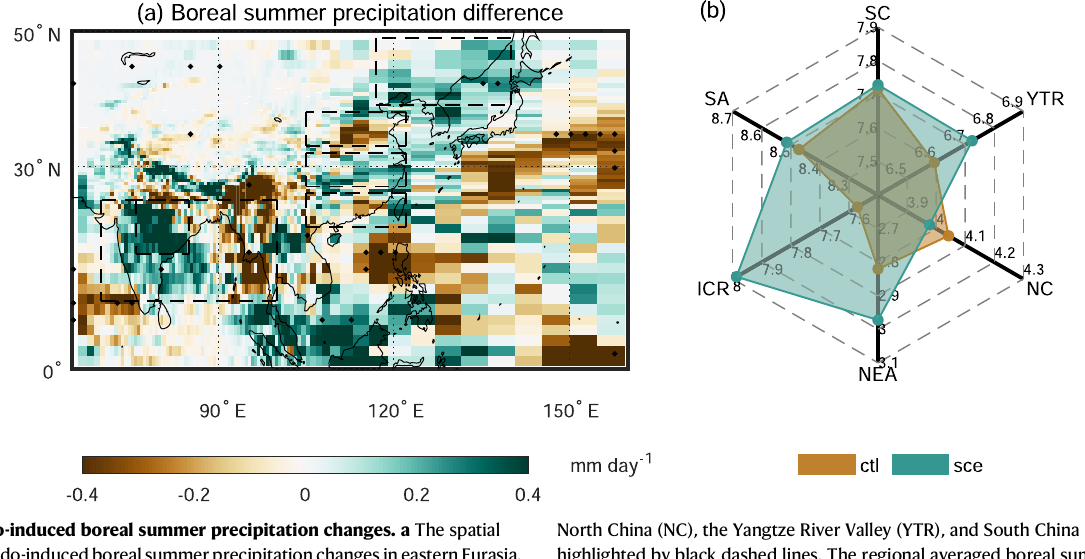
North China (NC), the Yangtze River Valley (YTR), and South China (SC), are highlighted by black dashed lines. The regional averaged boreal summer pre- cipitationinthesesixsubdivisionregionsisshowninpanel( b ).Theunitofthescale in the radar plot is mmday − 1 . More details about these regions are shown in the